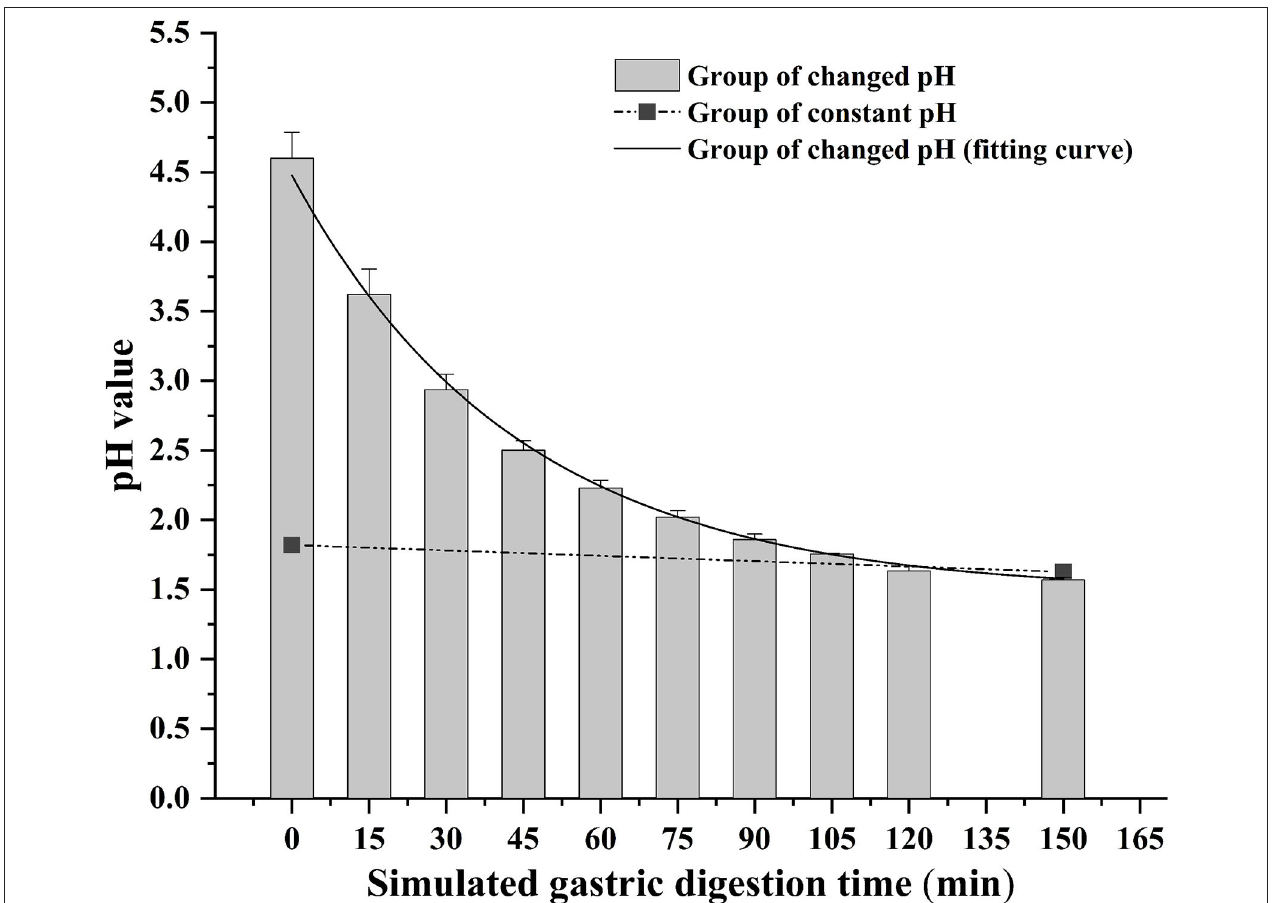
FIGURE 1 | Change of gastric pH during simulated digestion. The solid line is the fitted curve obtained for the pH varied group.